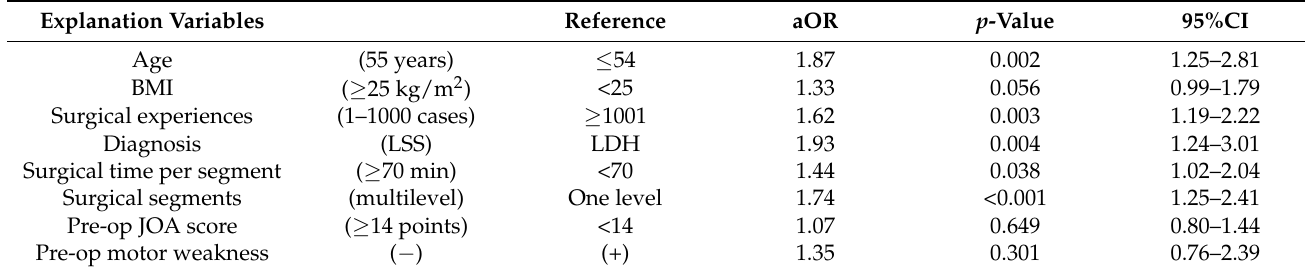
Table 4. Multivariate linear regression analysis (objective variables: postoperative spinal epidural